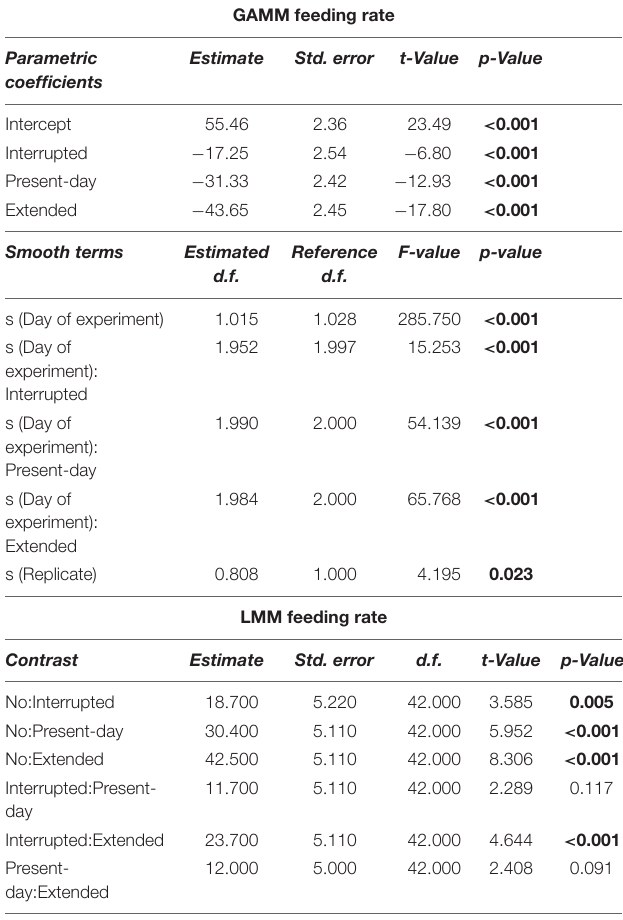
TABLE 1 | Generalized Additive Mixed-effect Model (GAMM) and Linear Mixed-effect Model (LMM) results for feeding rate (mg mussel dry weight per day) over 68 days of